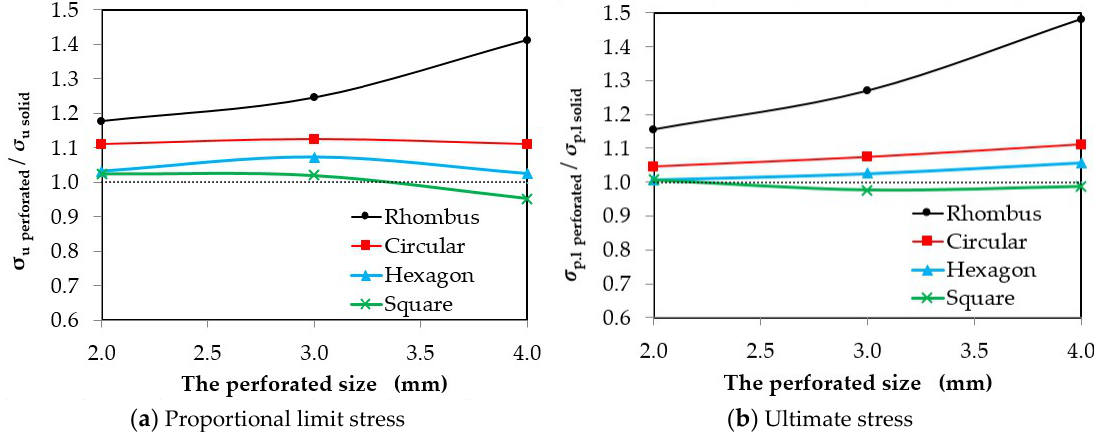
Figure 10. Relation between the ratio of perforated steel sheets stresses to control solid steel sheets and the influence of the perforated size.